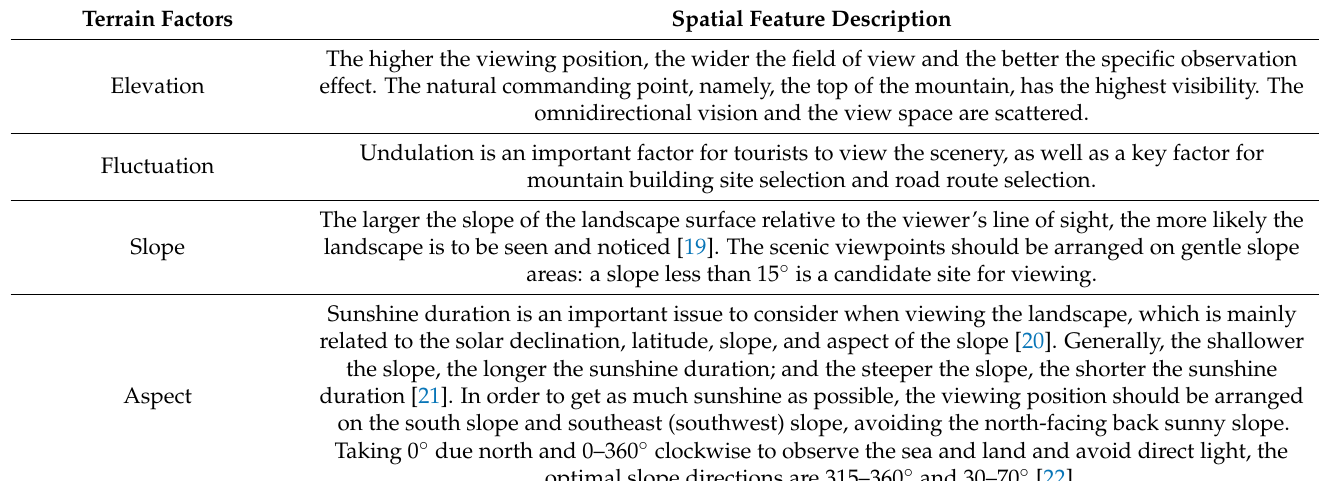
Table 1. Spatial characteristics of scenic viewpoints in the study area.